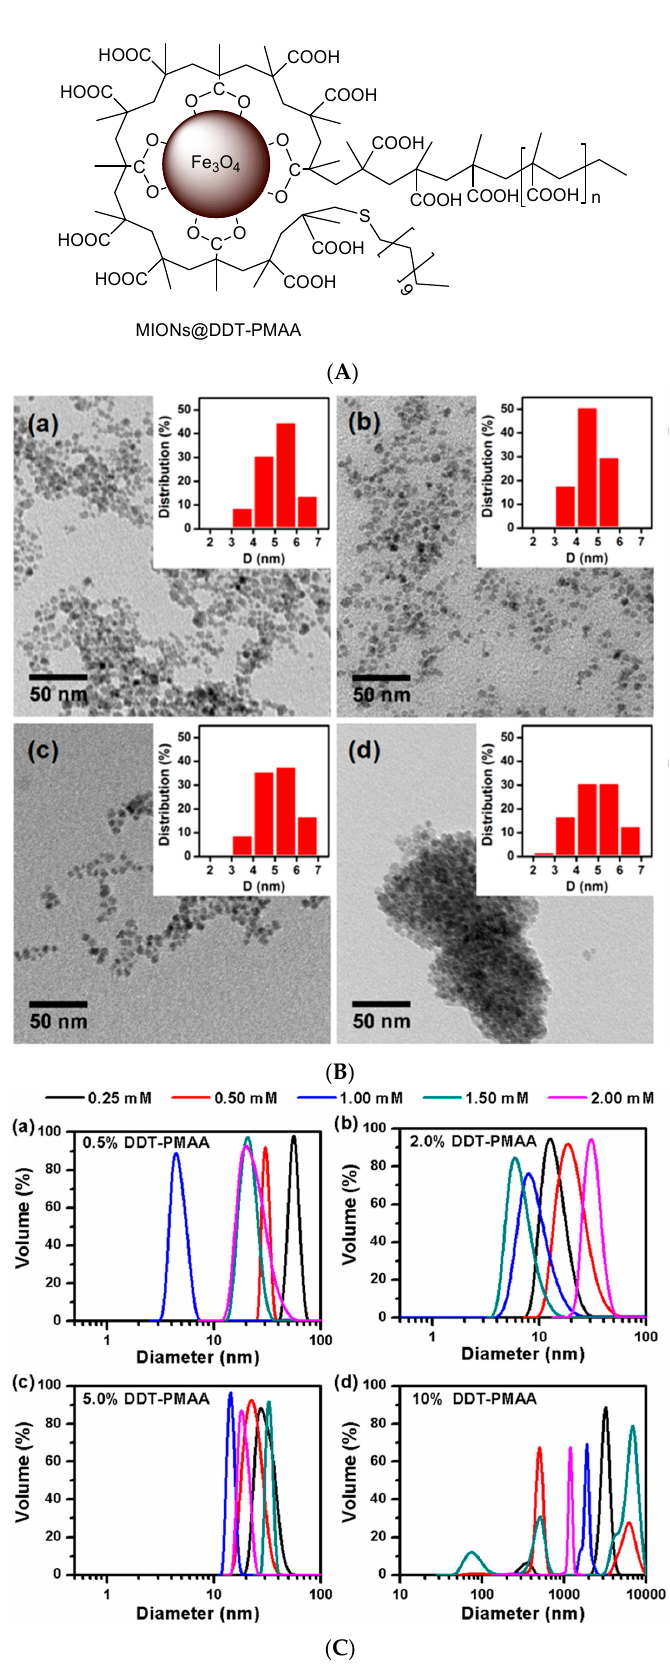
Figure 5. Scheme illustrating the ( i ) Synthesis of MIONs; ( ii ) TEM images ( a,b ) 4.5-nm and ( c,d ) 8.5-nm PMAA–PTTM protected Fe 3 O 4 nanocrystals. The molar ratio between carboxylic acid groups and FeCl 3 ·6H 2 O in both cases is 3:4 [57].